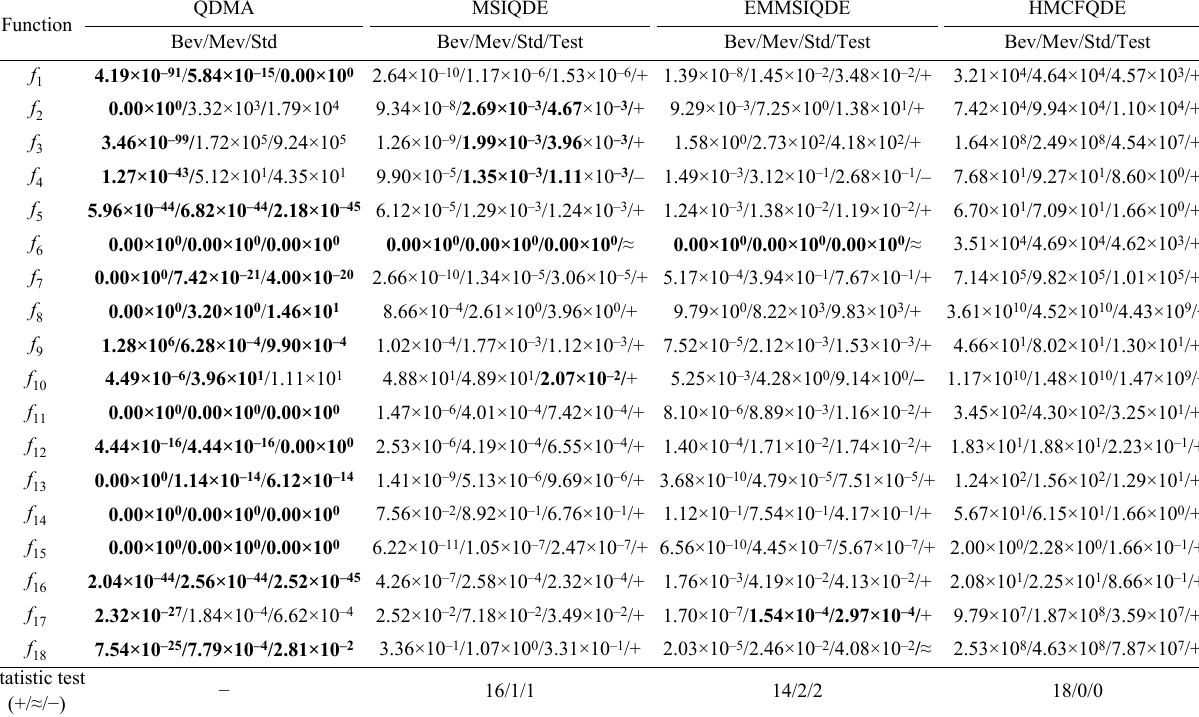
Table 3 Comparison of QDMA and state-of-the-art QEAs on 50 D